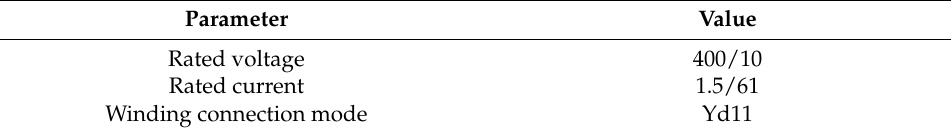
Table 2. Transformer parameters.